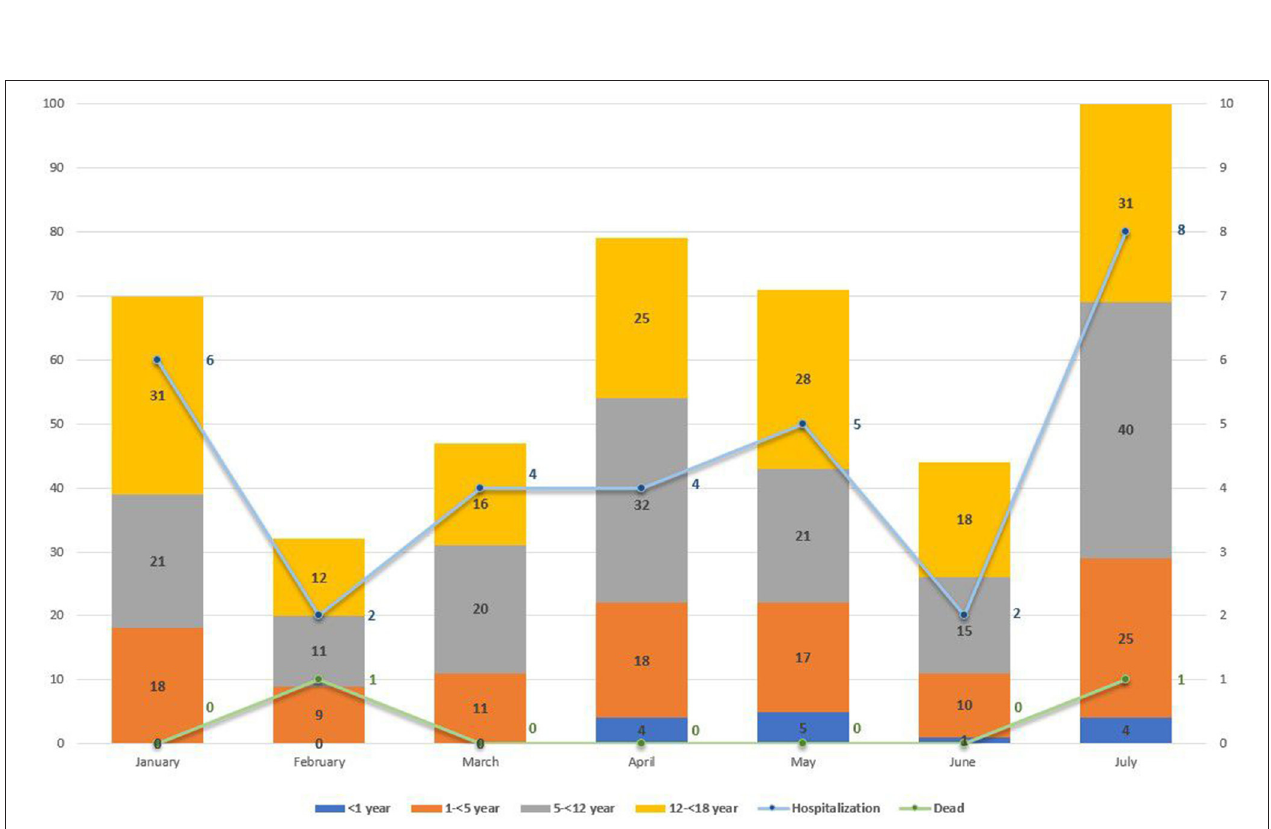
FIGURE 6 | New COVID-19 paediatric cases by age group (in year) from January to July 2021 at Murni Teguh Memorial Hospital, Medan. Line graph indicates number for pediatric COVID-19 cases with hospitalization and death from January to July 2021 at Murni Teguh Memorial Hospital, Medan.